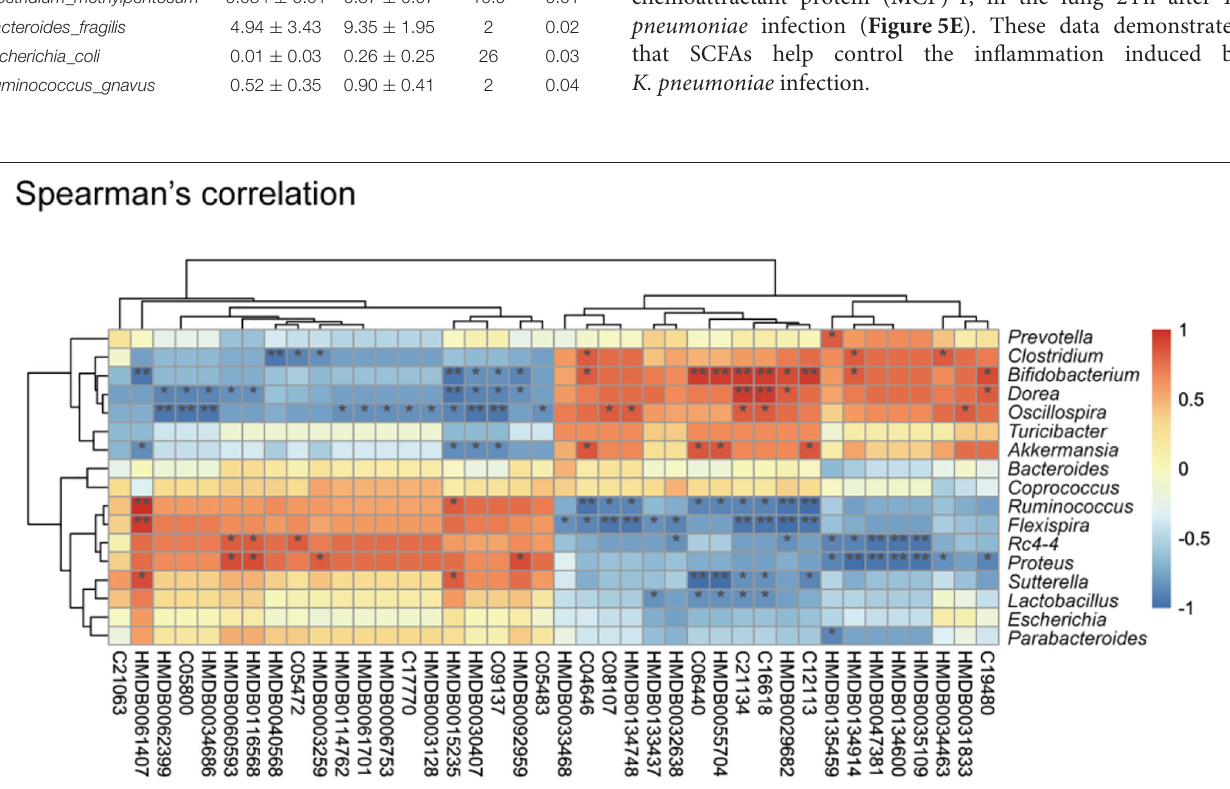
FIGURE 3 | Correlation between the cecal metabolome and fecal gut microbiota. Spearman’s rank correlation between cecum metabolites and associated gut microbiota in K. pneumoniae- infected mice and untreated controls. Red connections indicate a positive correlation, while blue connections are negative. P- values are determined by two-tailed Wilcoxon rank-sum test. * P < 0.05, ** P < 0.01.